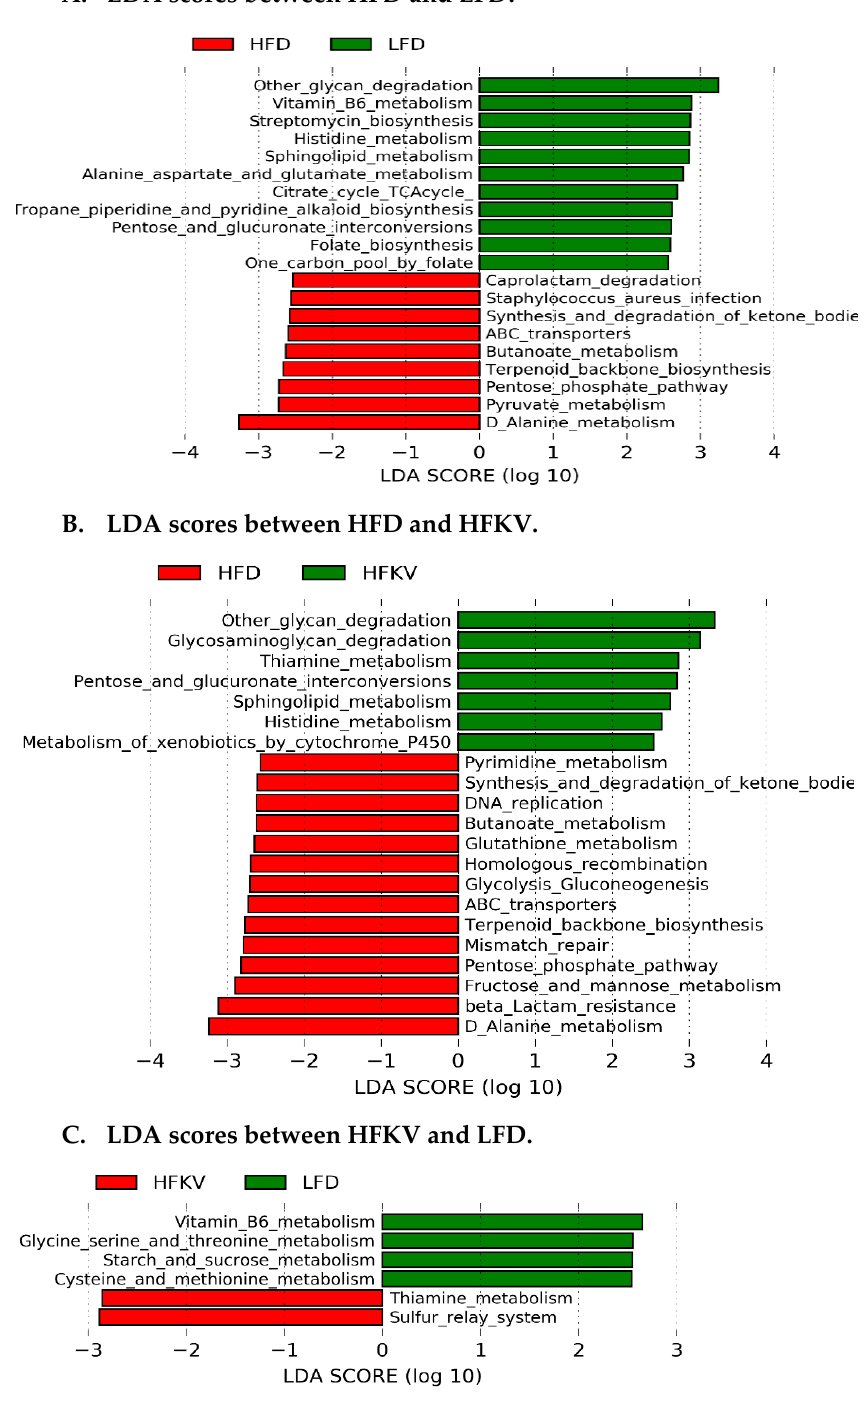
Figure 5. Linear discriminant analysis of predicted microbial metabolic functions. ( A ) Pathways induced by LFD and HFD; ( B ) Pathways induced by HFKV and HFD; ( C ) Pathways induced by LFD and HFKV.